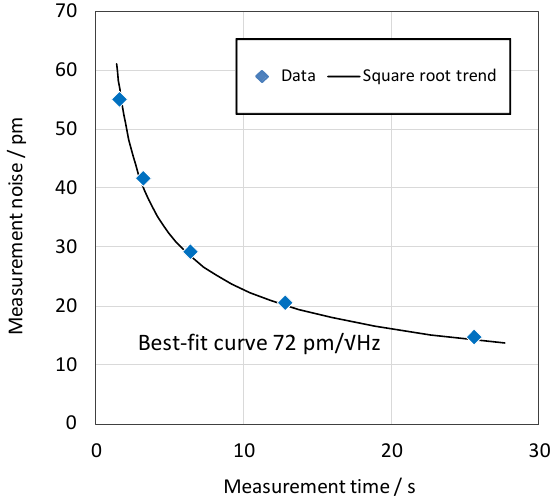
Figure 2. Experimental demonstration of the reduction of measurement noise as a function of data acquisition time for the ZYGO Nexview™ 3D interference microscope.